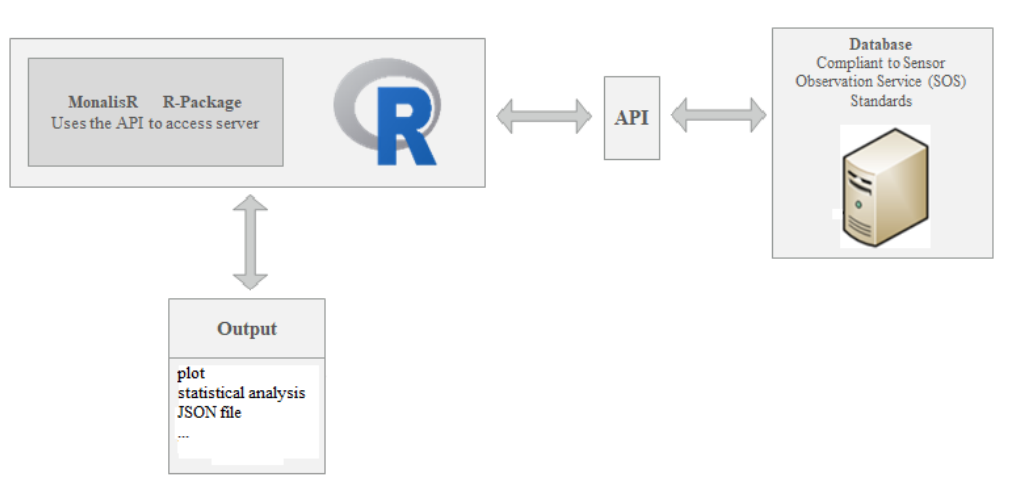
Figure 9. Schematic representation of the workflow to visualize SOS data using